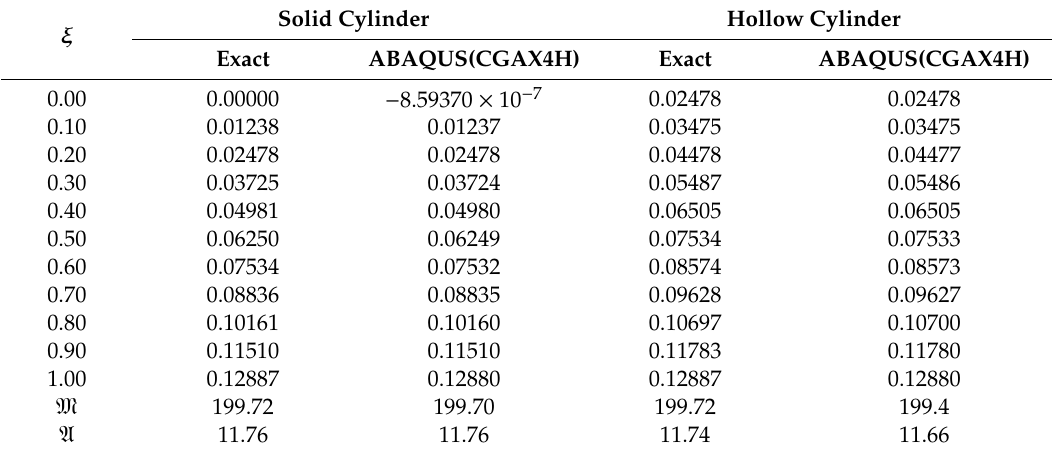
Table 6. Shear stress (MPa), torque (kN · mm) and normal force (kN) of simple torsion